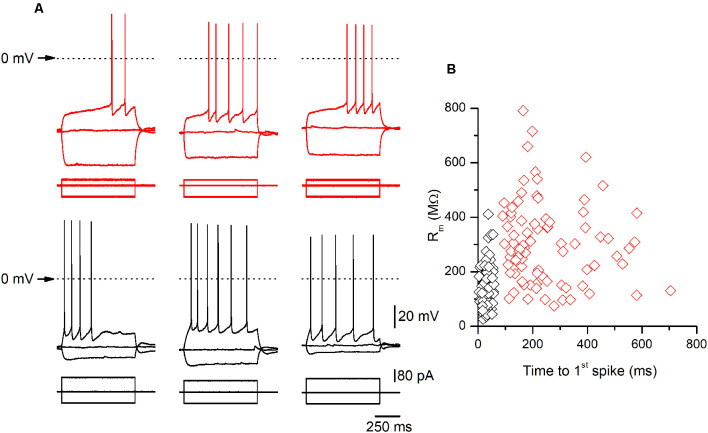
Examples of late-spiking (LS) and non-LS pyramidal neurons. (A) Examples of the responses to hyperpolarizing and depolarizing current pulses of three LS (upper panels, red traces) and three non-LS pyramidal neurons (lower panels, black traces). Note the clear subthreshold slow depolarization in LS neurons, which is absent in the non-LS neurons. The hyperpolarizing pulse was of the same magnitude in all neurons (−80 pA) to illustrate the difference in input resistance (IR) between both types of neurons. The depolarizing current pulse was +40 pA in LS neurons (threshold pulse strength) and +80 / +100 pA in the non-LS neurons (minimum pulse strength necessary to evoke tonic discharge). The dotted line marks the 0 mV level. The scale bars apply to all panels. (B) The relationship between the input membrane resistance and time to 1st spike in LS (red symbols) and non-LS neurons (black symbols). The input resistance (Rm) was measured from the responses to small hyperpolarizing current pulses, and the time to 1st spike was measured between the onset of the depolarizing current pulse and the peak of the first spike fired by a depolarizing current pulse of strength corresponding to the rheobase.